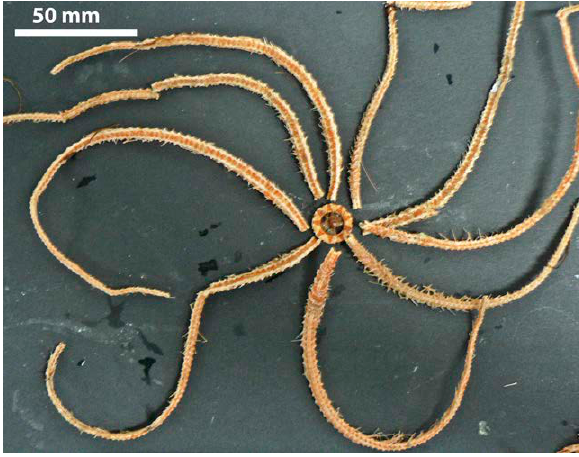
Fig. 4. – Hymenodiscus coronata